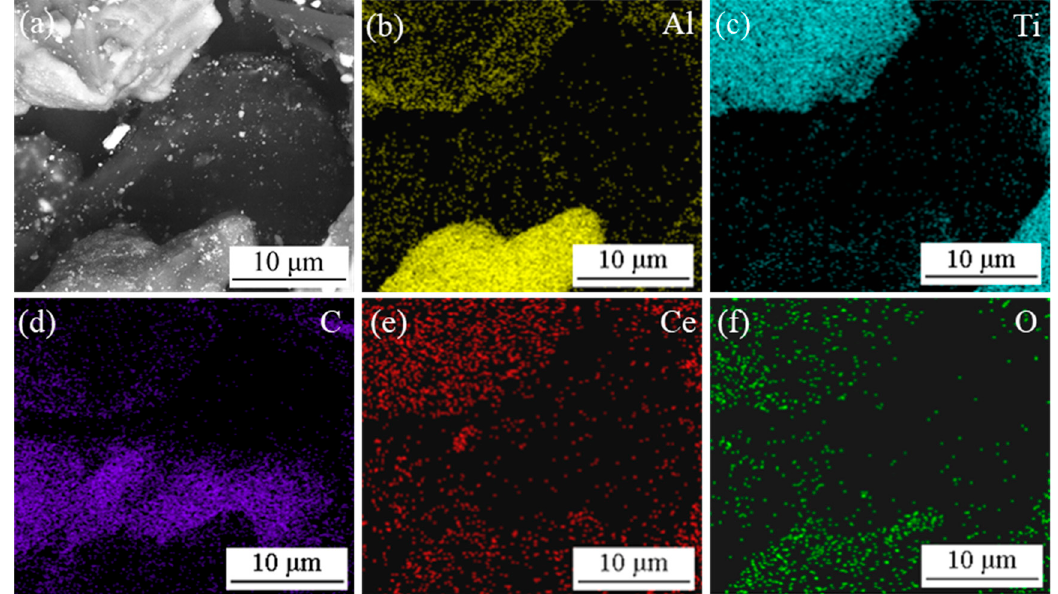
Figure 3. SEM image and map scanning patterns of Area 1 in Figure 2d: ( a ) SEM image; ( b – f ) map scanning patterns of Al, Ti, C, Ce and O elements, respectively.